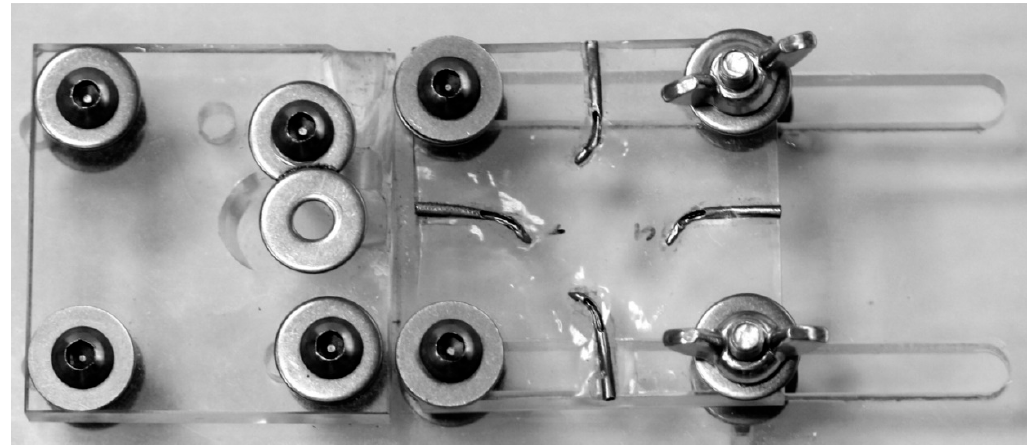
Figure 1. Static cyclic fatigue device with embedded stainless steel artificial root canal systems.